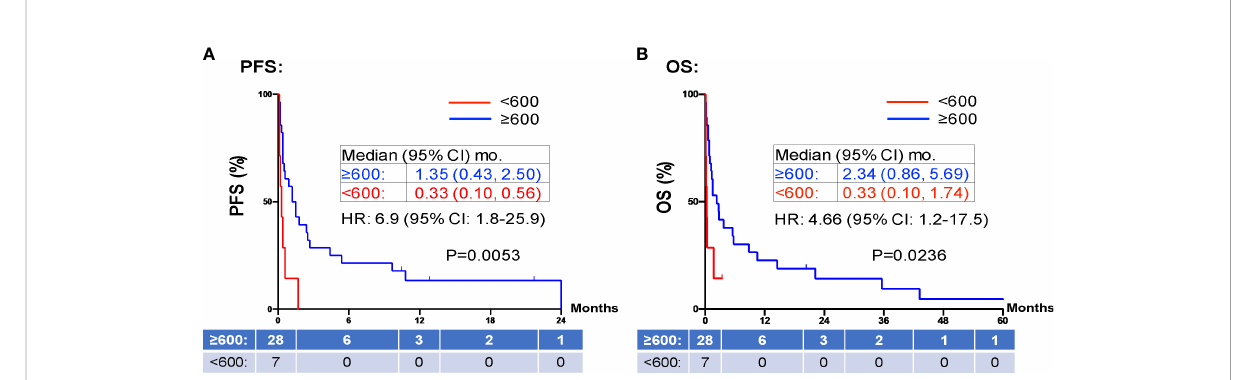
FIGURE 4 PFS and OS strati fi ed by ALC. Patients with high ALCs ( ≥ 600 K/mm 3 shown in red) prior to inpatient treatment was associated with shorter PFS (A) and OS (B) compared to those patients with low ALCs (<600 K/mm 3 shown in blue). Groups were compared using the log-rank test. Tick marks indicate censored data. P<0.05 for statistical signi fi cance. ALCs, absolute lymphocyte counts; dNLR, derived-neutrophil-to-lymphocyte ratio, PFS, progression free survival; OS, overall survival.